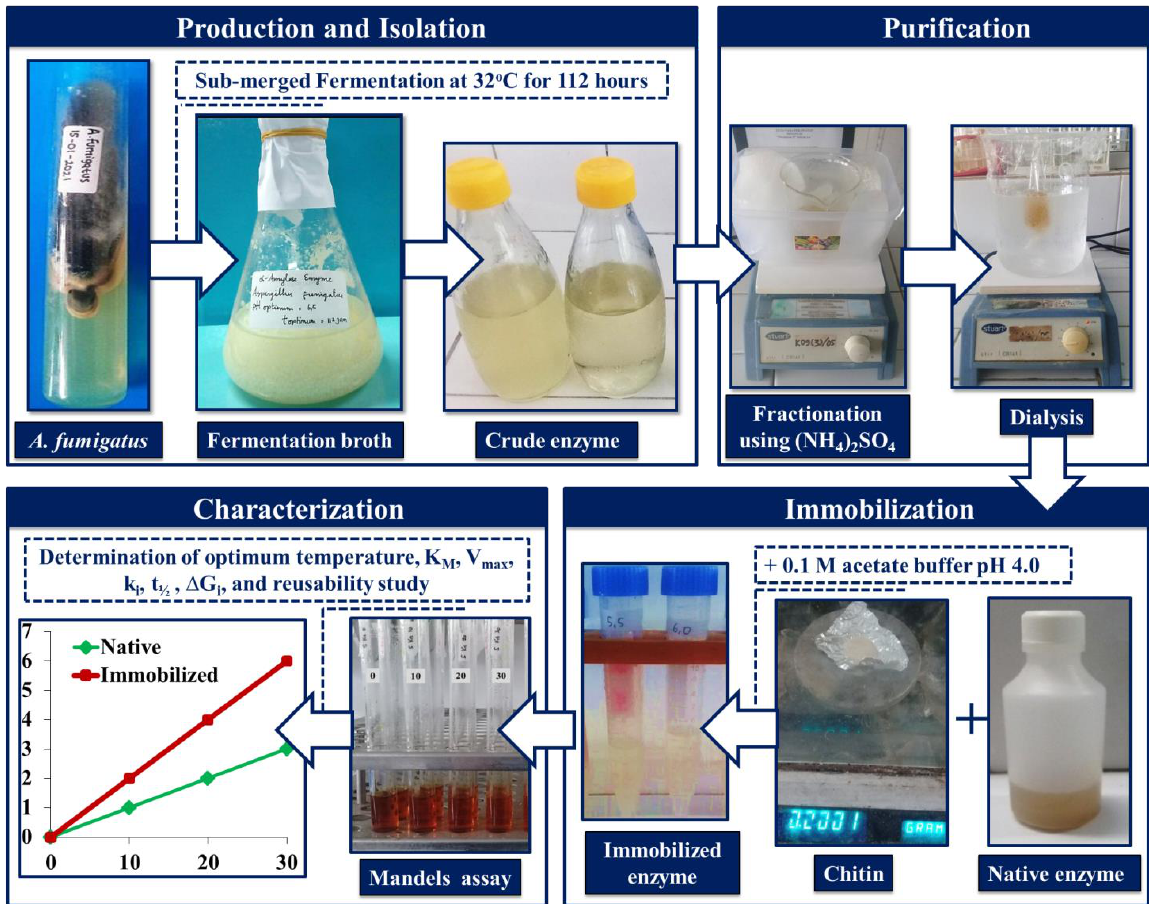
Figure 1. The flowchart of the